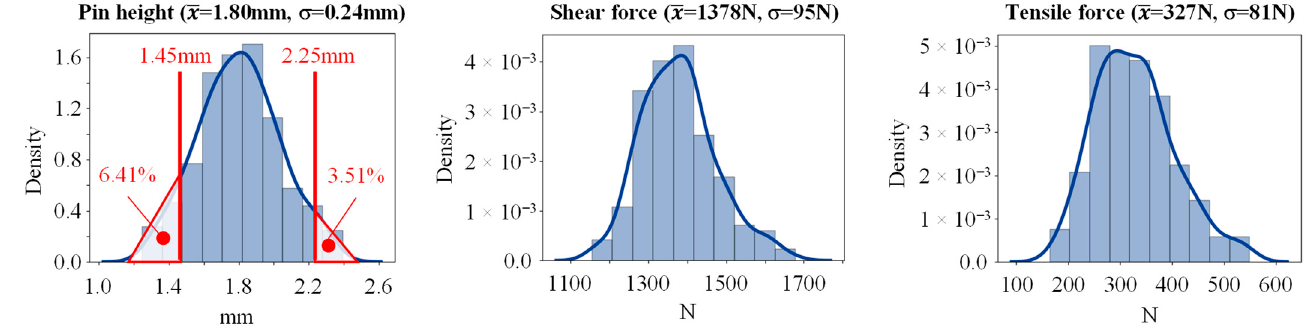
Figure 12. Property distributions and failure probability of pin joint characteristics.